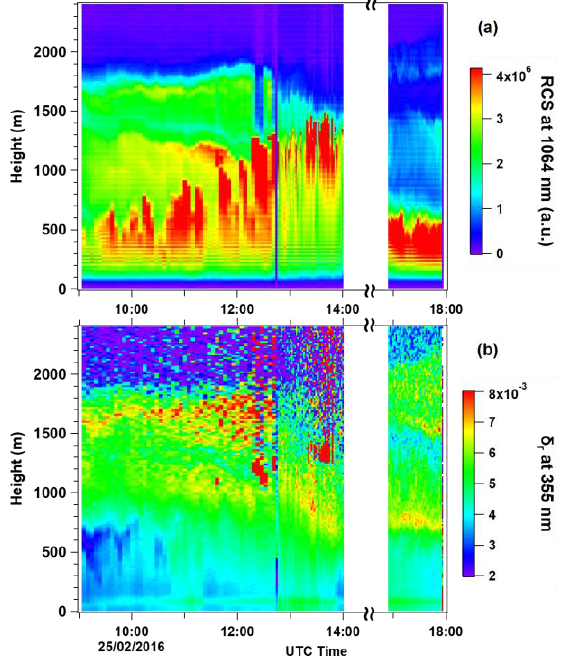
Figure 1 Color plot of the temporal evolution of (a) the range corrected lidar signal (RCS) at 1064 nm and (b) the linear volume depolarization ratio (  r ) at 355 nm on 25 February